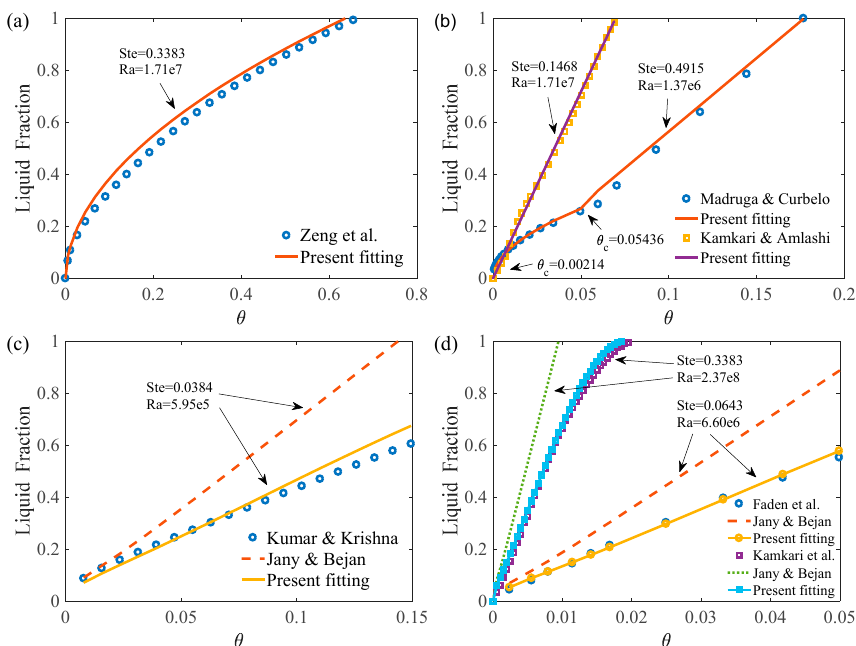
Figure 17. Validation of the results of the references by using the proposed fitted correlations. ( a ) Heating the top side [39]; ( b ) heating the bottom side [20,28]; ( c ) heating the lateral side [41]; ( d ) heating the lateral side [36,40]. Table 3. The parameters from the references.